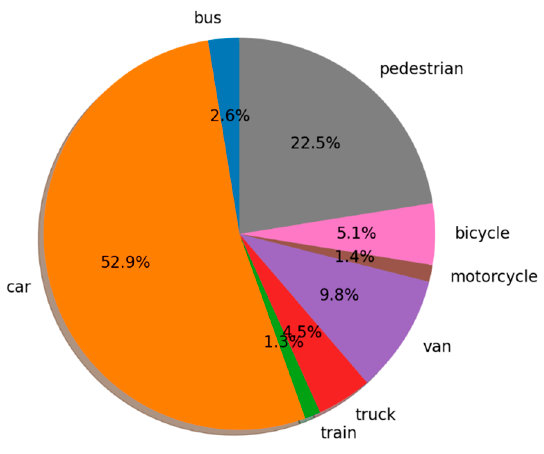
Figure 7. Class distribution.